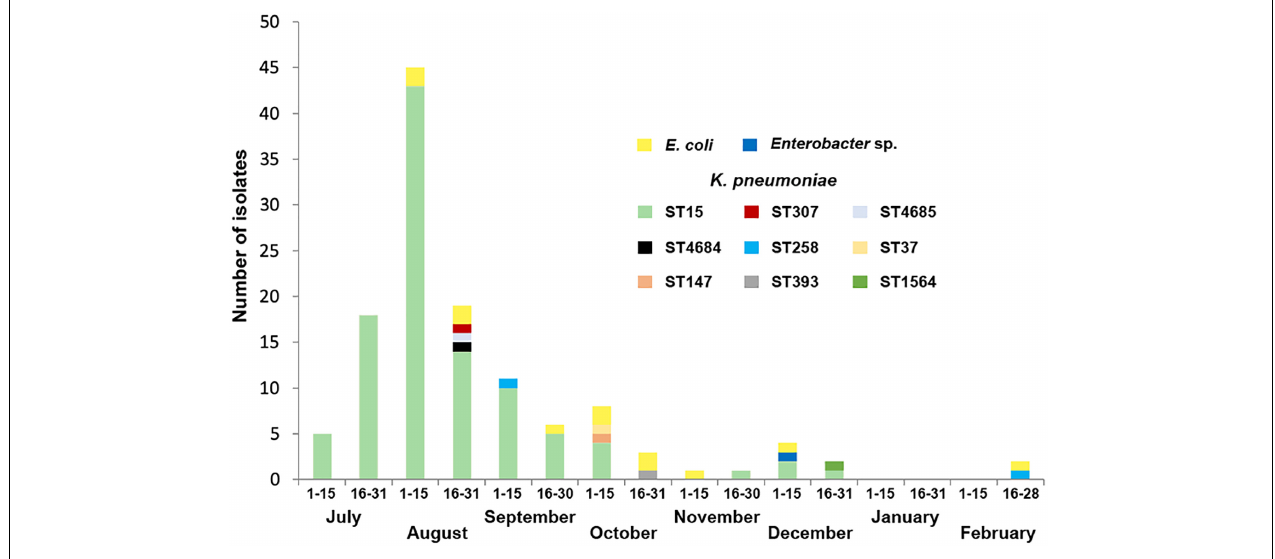
FIGURE 1 | Temporal distribution of KPC-producing K. pneumoniae isolates according to sequence types (STs) as well as KPC-producing E. coli and Enterobacter sp. isolates recovered in this